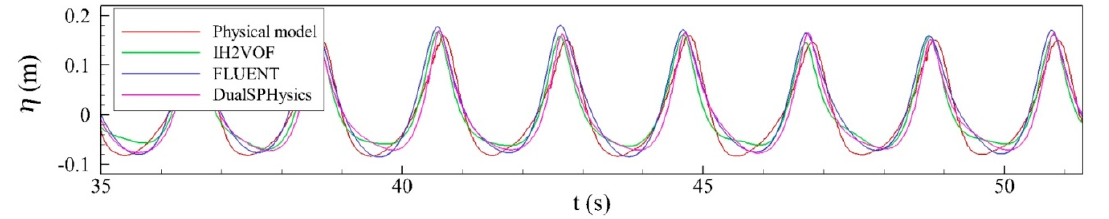
Figure 10. Time series of surface elevation for test 5 at section x = 3.0 m.